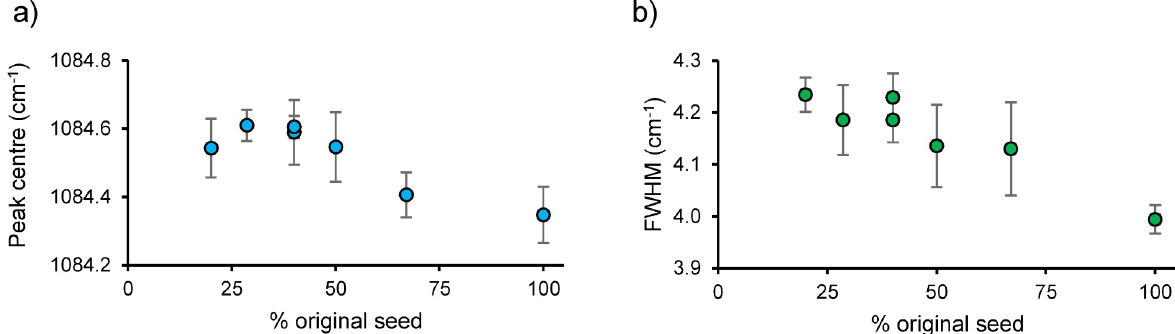
Fig 7. Peak centre and FWHM of the ν 1 peak in the Raman spectra of precipitates containing different proportions of seed and in vitro precipitate. a) Peak centre and b) Full width half maxima. The signatures of the seed are shown by the point at 100% seed. Points are means of 10 spectra and error bars are 1 standard